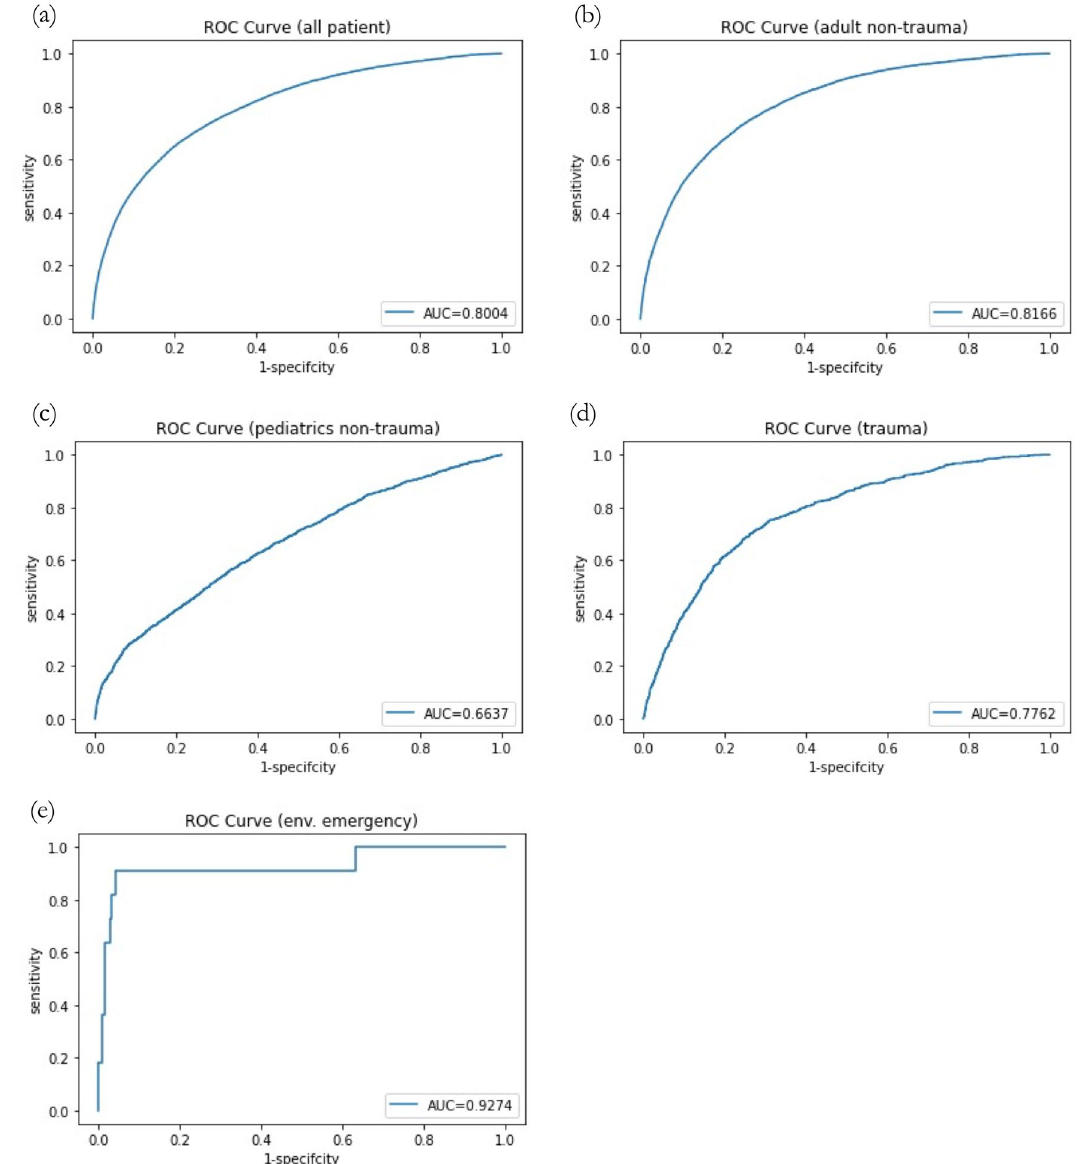
Figure 1. The receiver operating characteristic (ROC) curves of the predictive model for all patients and subgroups. ( a ) All patients. ( b ) Nontraumatic adult patients. ( c ) Pediatric patients. ( d ) Traumatic patients. ( e ) Patients of environmental emergency.